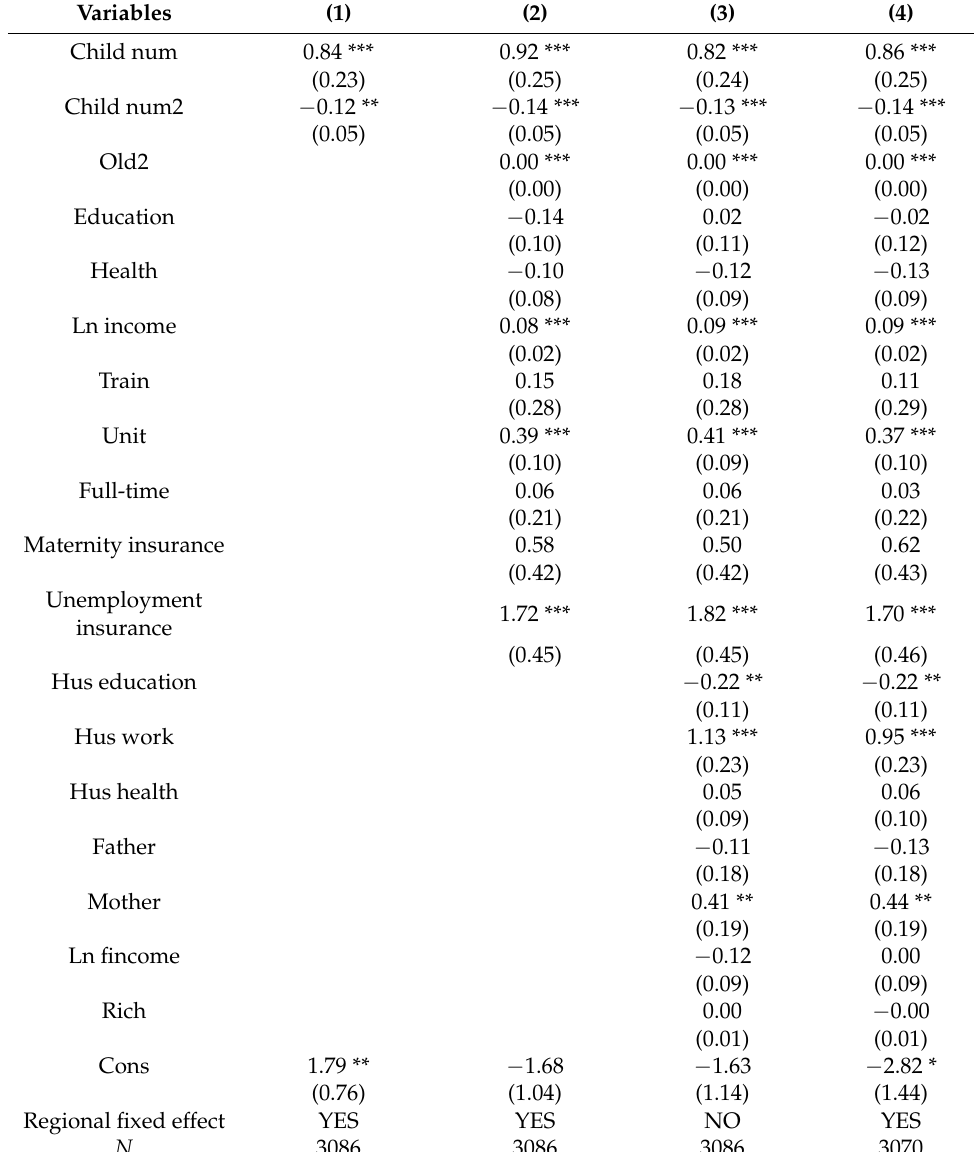
Table 5. Robustness: replacement regression models (logit